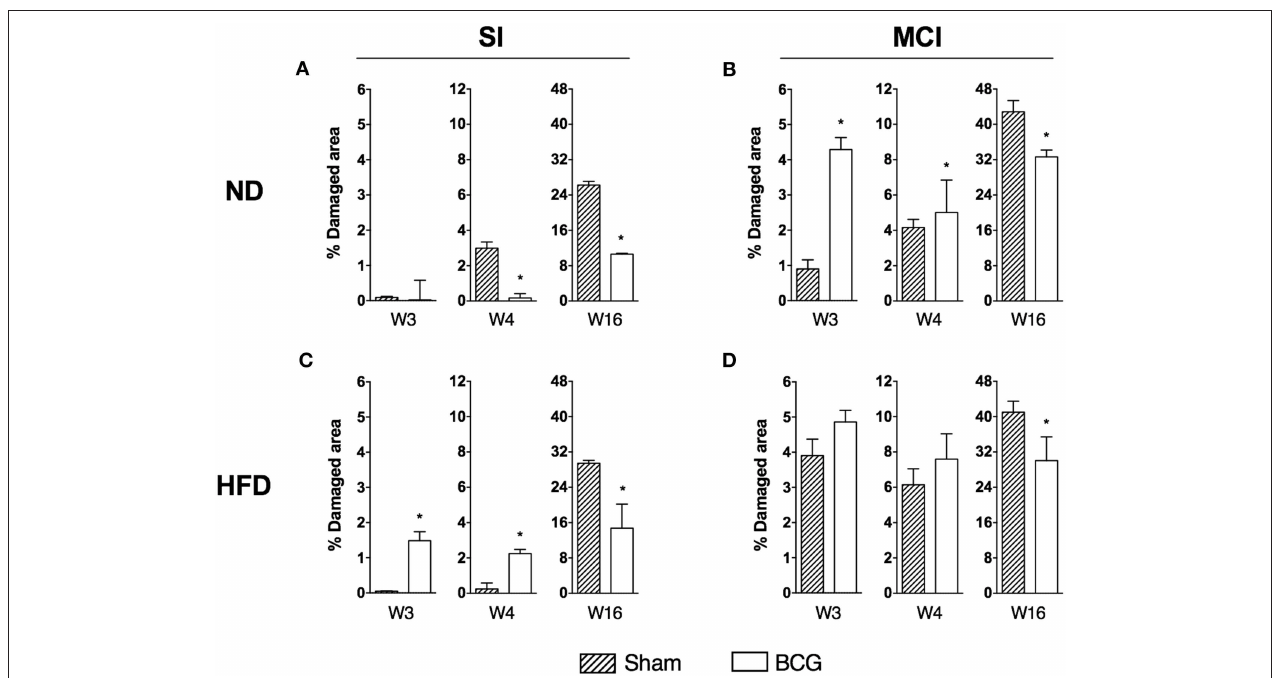
FIGURE 3 | Progression of lung disease at different end time points (w3, w4, and w16) is shown as the percentage of damaged area. Each panel compares sham and BCG vaccinated groups: ND and SI (A) , ND and MCI (B) , HFD and SI (C) , HFD and MCI (D) . Bar plots show median with range. * p < 0.05; Mann–Whitney test.